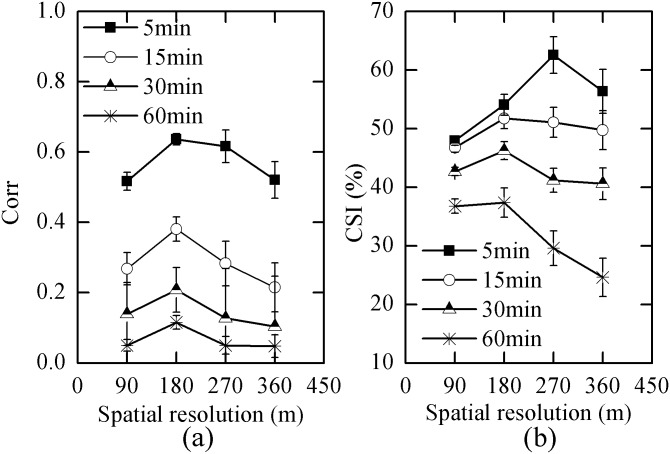
Average Corr and CSI of 3 events for 0–60 min predictions vs. different spatial resolutions of radar using PPLK.